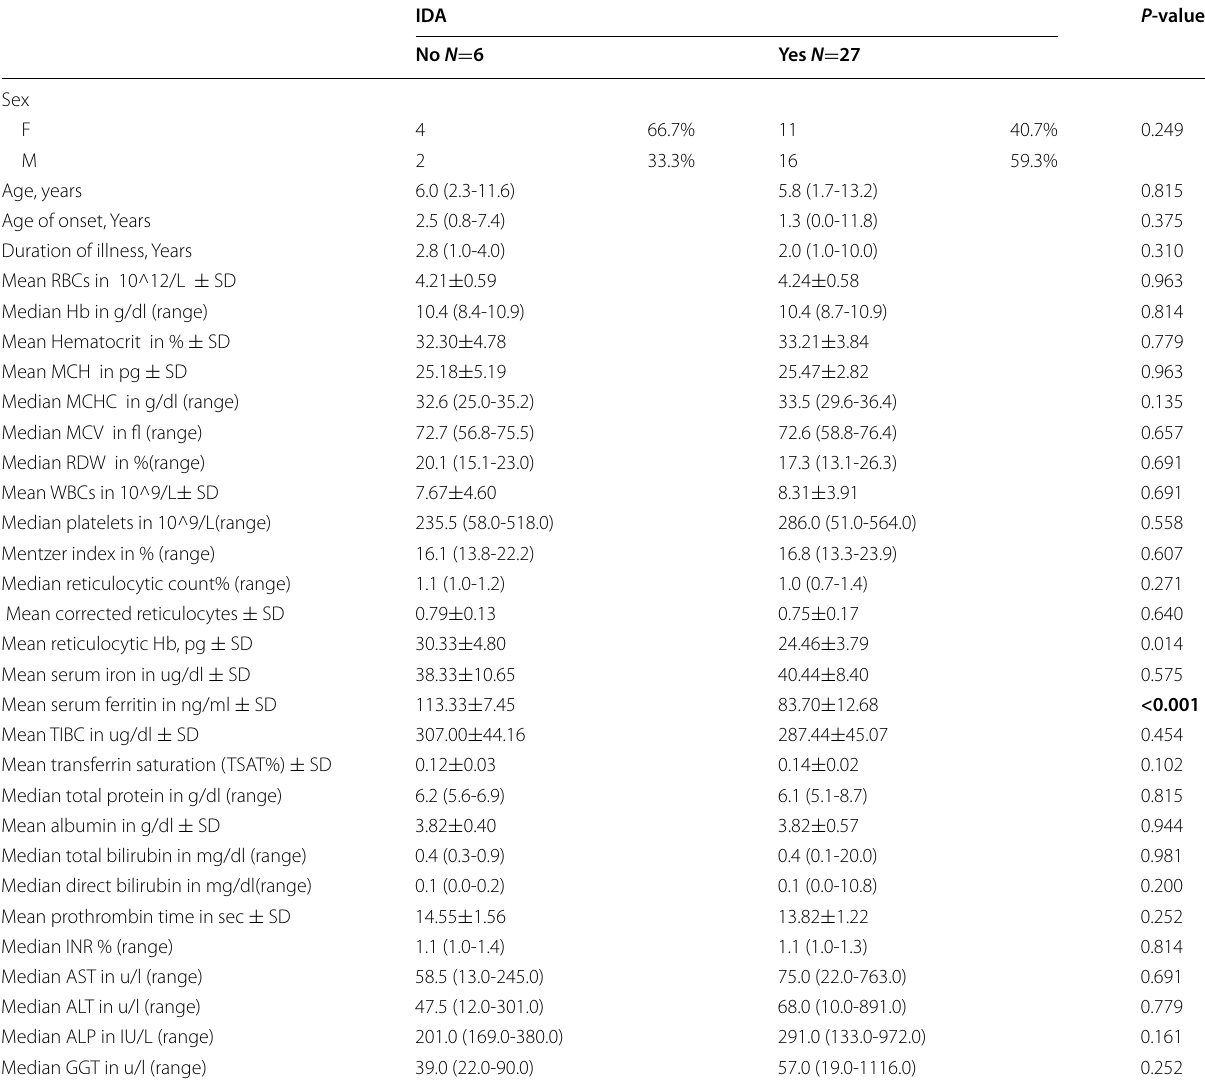
Table 3 Characteristics of patients as regard the presence of Iron Deficiency Anemia ( N